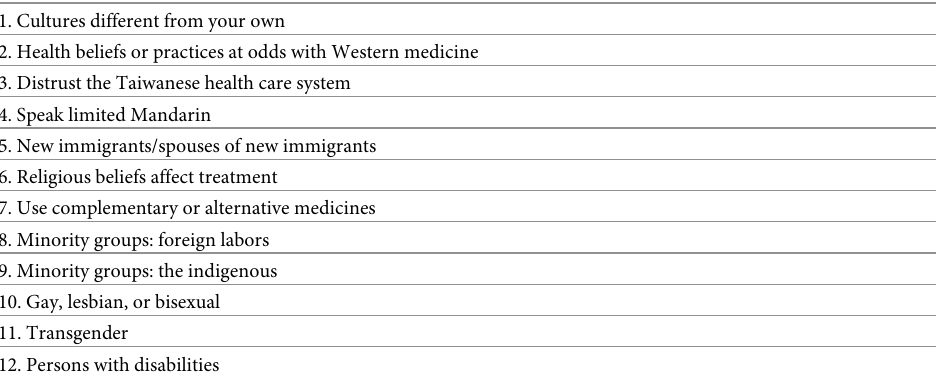
Table 1. Diverse groups included in cross-cultural care competence